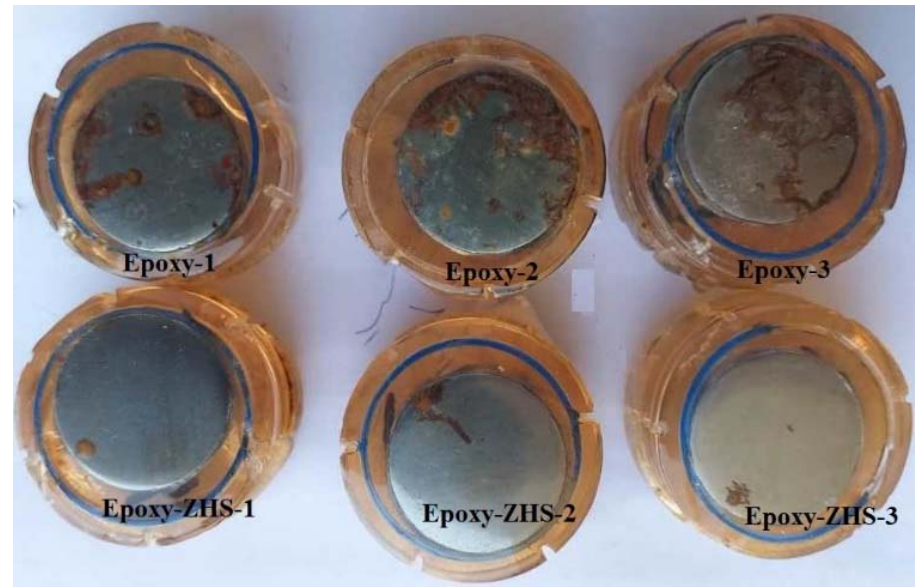
Figure 12. The visual images of the neat and ZHS ‐ containing epoxy coatings after the corrosion tests. In addition, FESEM and EDS-mapping analyses were performed to study the mor- phology and chemical composition of the corrosion products, respectively. The parts of the epoxy sample that did not appear to be damaged by the corrosion process were examined at higher magnifications using the FESEM (Figure 13a,b). It is clear that even those parts are seriously damaged by corrosion. The formation of holes with a diameter of several tens of micrometres is obvious. In the high-magnification image (Figure 13b), the formation of crystals, most likely iron oxide/hydroxide, is visible. Corrosion product accumulation was confirmed by examining the elemental map of the affected area. There are large amounts of iron and oxygen as well as chlorine in the damaged area, indicating the formation of iron hydroxide/oxide as well as iron chloride in the damaged area (Figure 13c 1–5 . In addition, the lack of carbon in the mentioned area means that there is no epoxy coating in the damaged area, which is also evident in the relevant microscopic